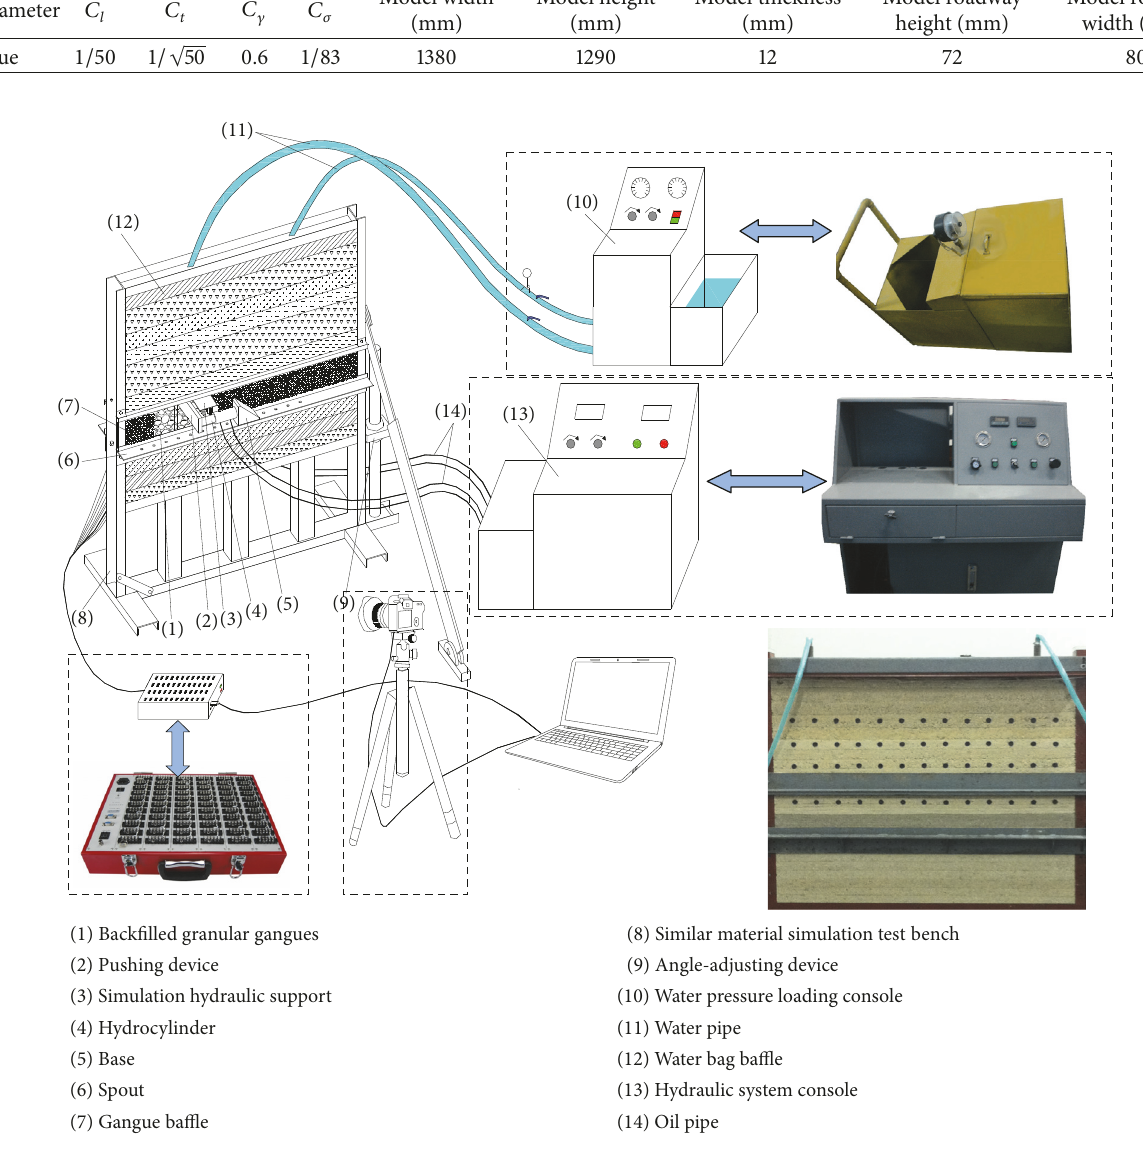
Figure 4: Backfilling GER similar model test